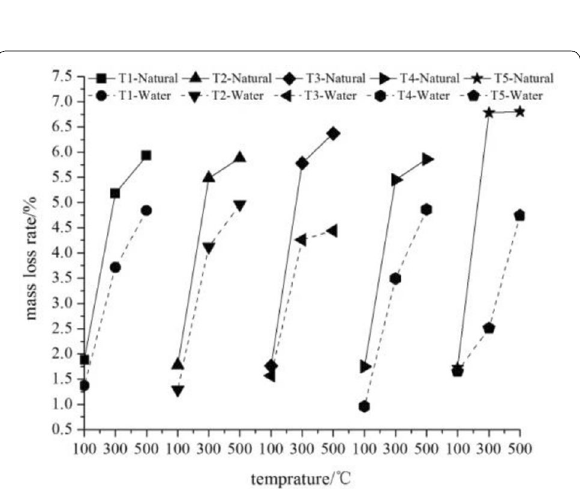
Fig. 9 Relation between the mass loss rate of concrete produced with desert sand and temperature under different